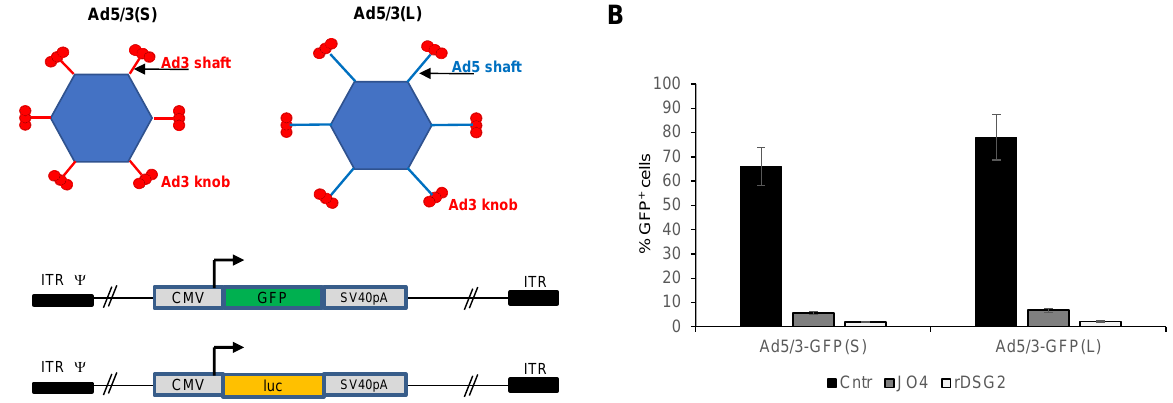
Figure 1. In vitro transduction studies with Ad5/3(L) and Ad5/3(S) vectors. ( A ) Vector structure. Upper panel: Vector capsids. Both vectors are based on Ad5. Ad5/3(S) contains the Ad5 fiber tail, the “short” (S) Ad3 fiber shaft and the Ad3 fiber knob. (Ad fibers are homotrimers, which are depicted by three fiber knobs.) Ad5/3(L) contains the original “long” (L) Ad5 fiber shaft and Ad3 fiber knob. Lower panel: Two sets of E1/E3 deleted (first-generation) Ad5/3(S) and Ad5/3(L) vectors